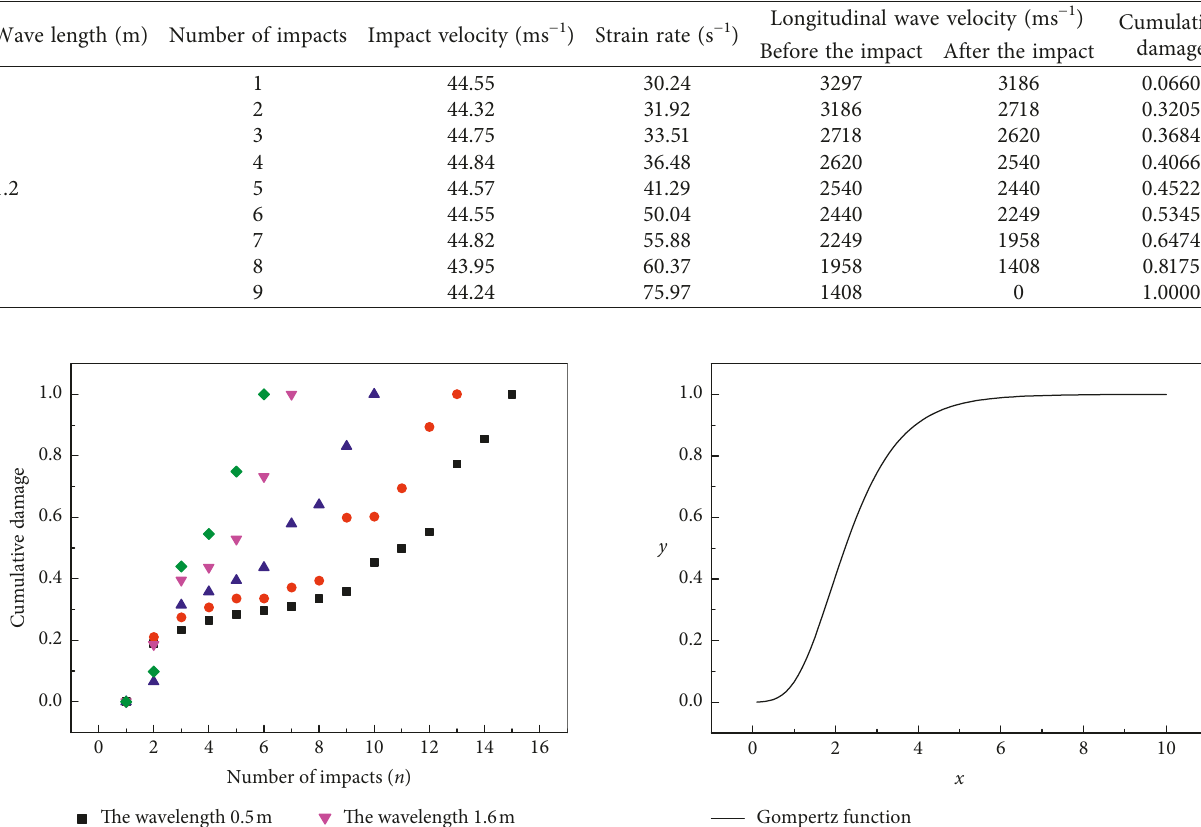
Table 3: Damage of siltstone under nine times stress waves loadings at 1.2m wavelength.